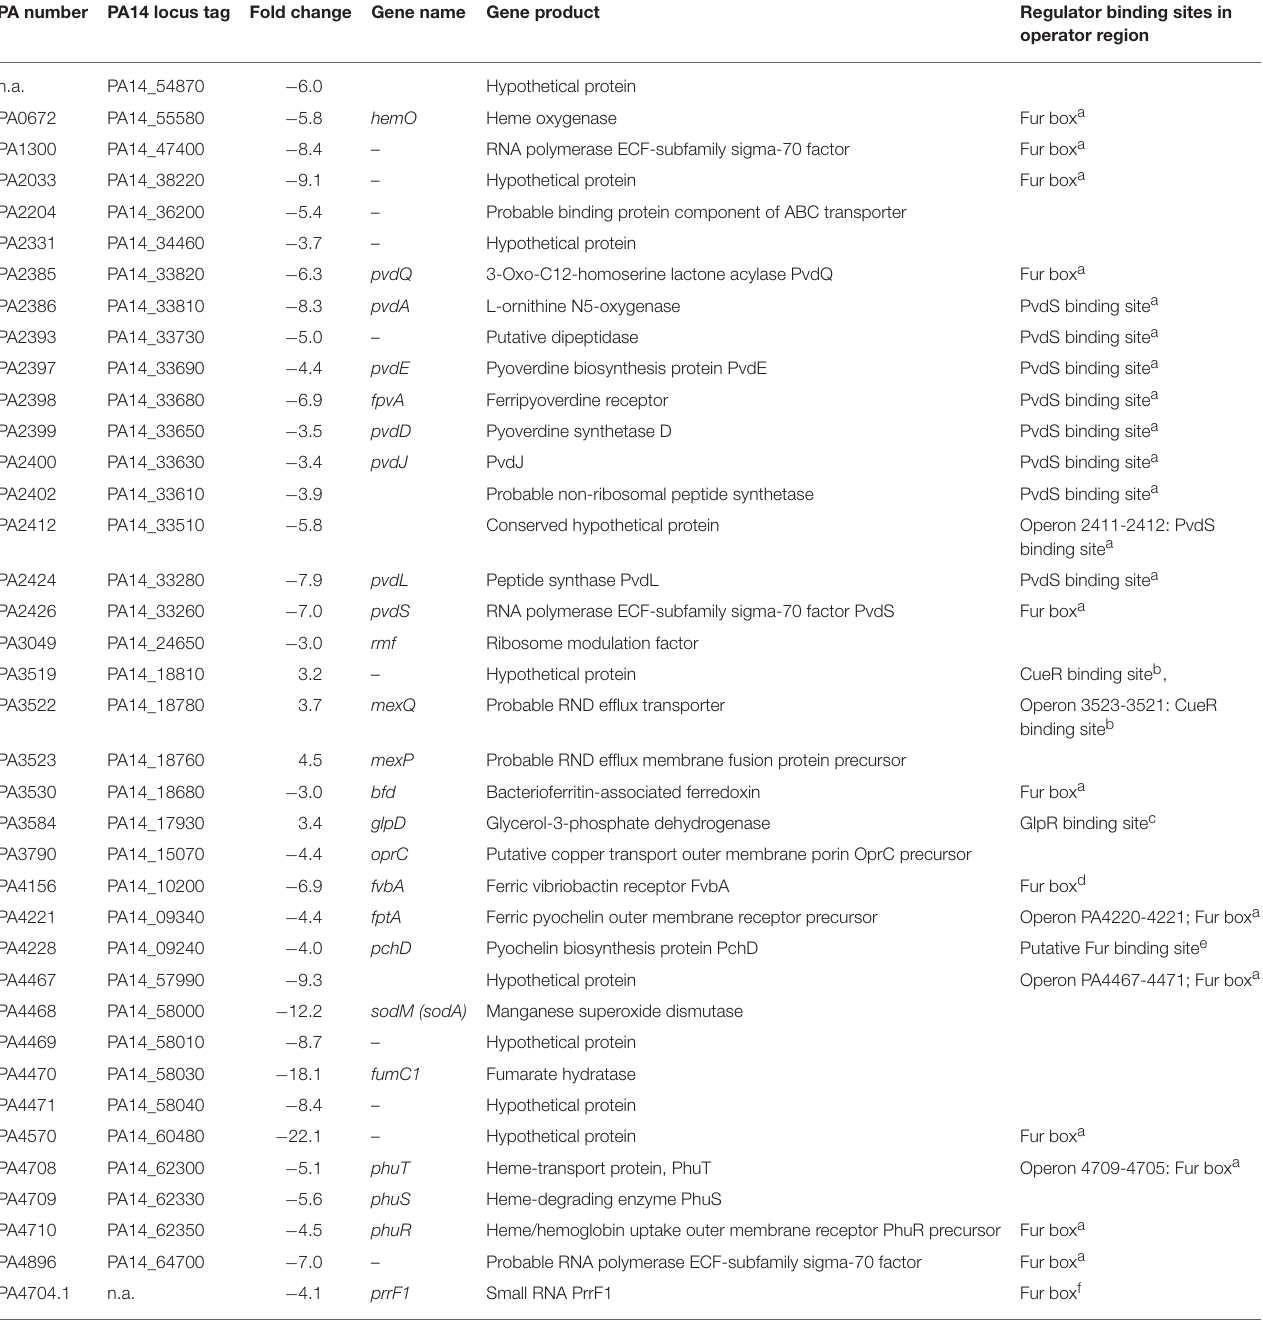
TABLE 2 | Genes of P. aeruginosa PA14 lasB ::Tn with decreased expression in presence of HodC. PA number PA14 locus tag Fold change Gene name Gene